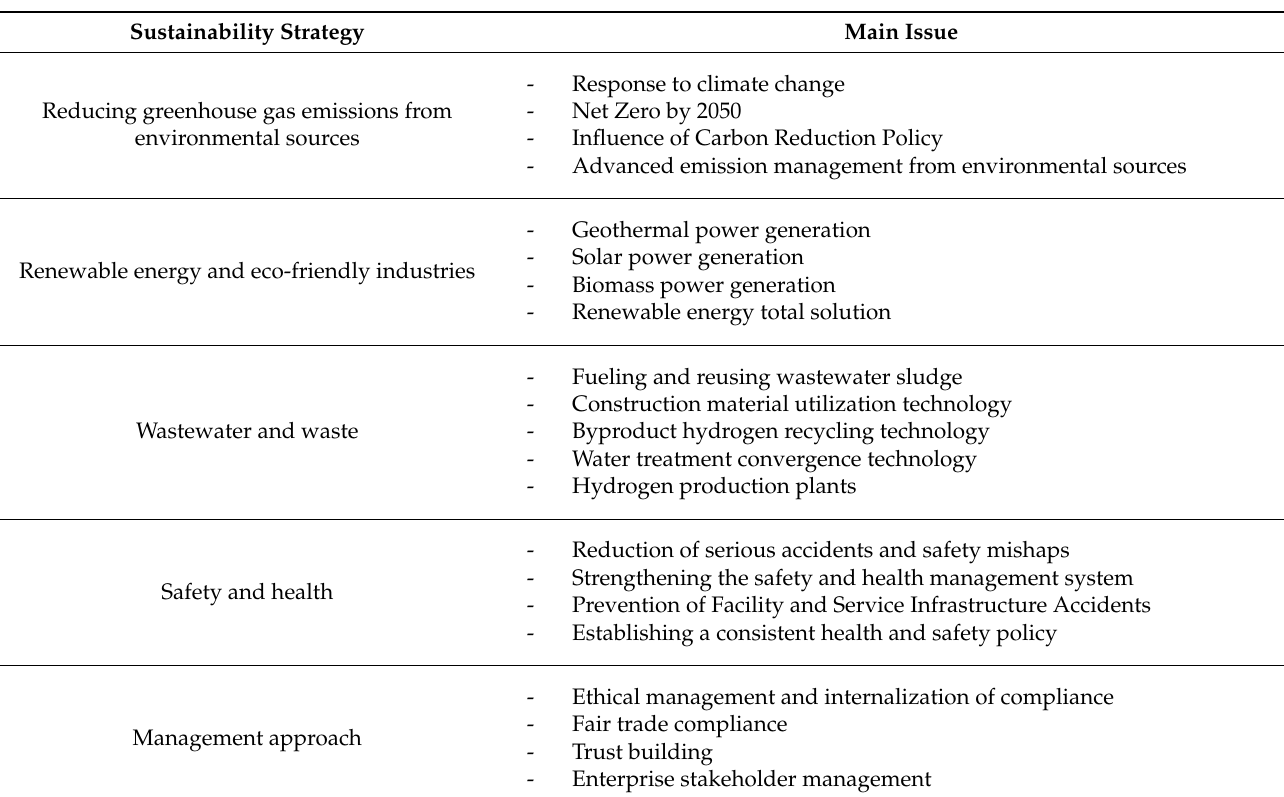
Table 13. Sustainability strategies for the construction